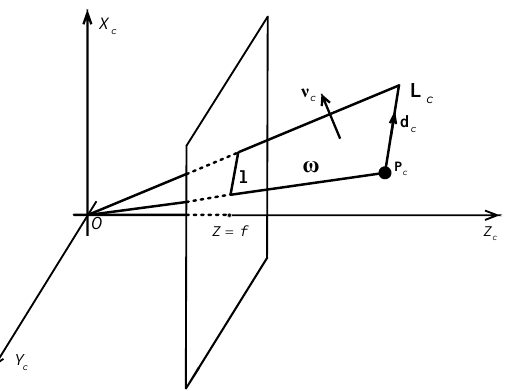
Figure 10. The schematic diagram of Equation (7) to Equation (12). L c represents the structure, l represents the projection of L c , and w is the projection plane while v c is the normal vector of w . The basic idea of Equation (6) is to minimize the reprojection error of